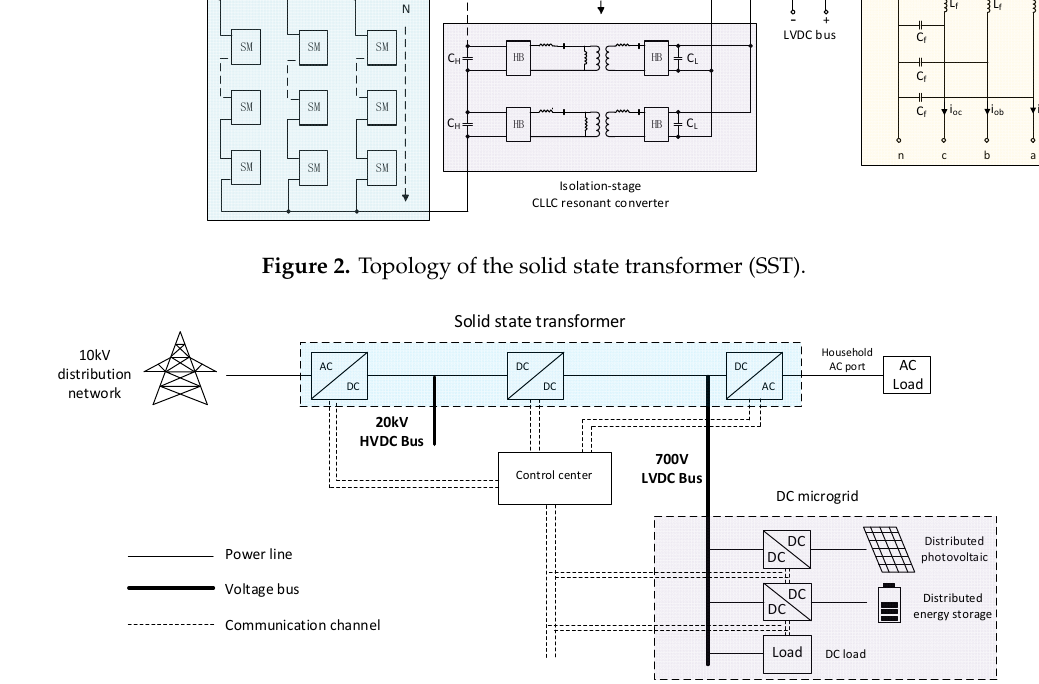
Figure 2. Topology of the solid state transformer (SST).